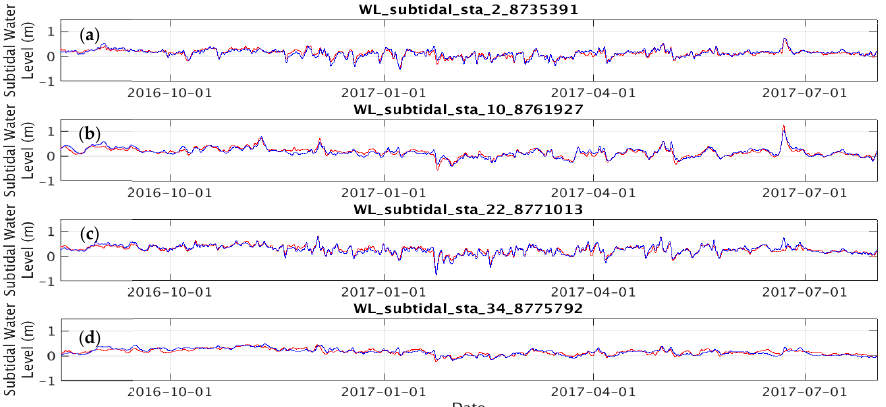
Figure 8. Comparison of model (red lines) and observed (blue lines) water levels at CO-OPS water level stations ( a ) 8735391, ( b ) 8761927, ( c ) 8771013, and ( d ) 8775792. See the station locations in Figure 1.